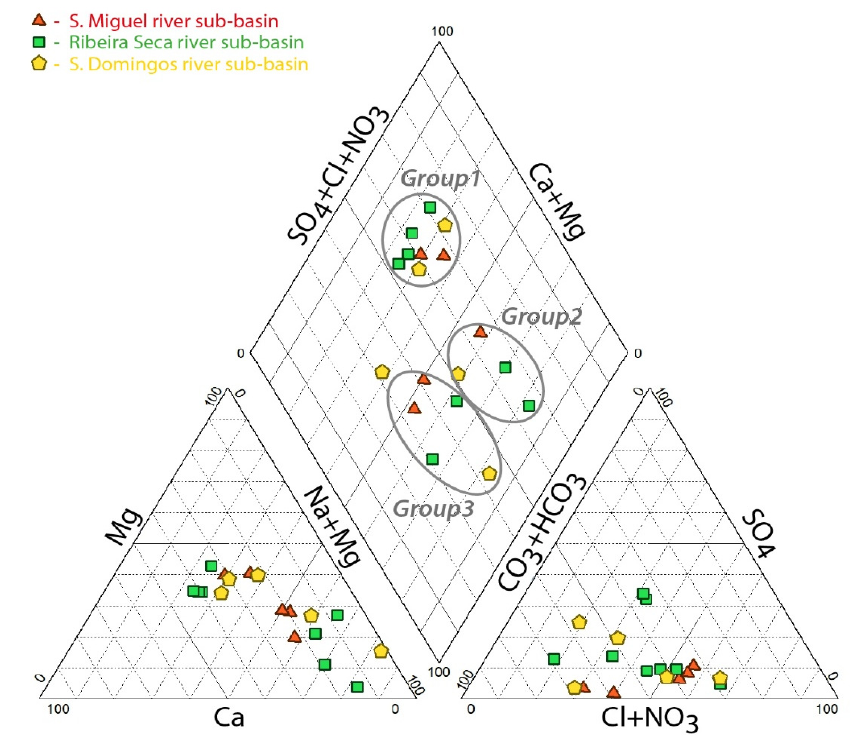
Figure 9. Hydrochemistry classification (Piper diagram) of the S. Miguel, Ribeira Seca and S. Domin- gos river sub-basins for summer of 2016.